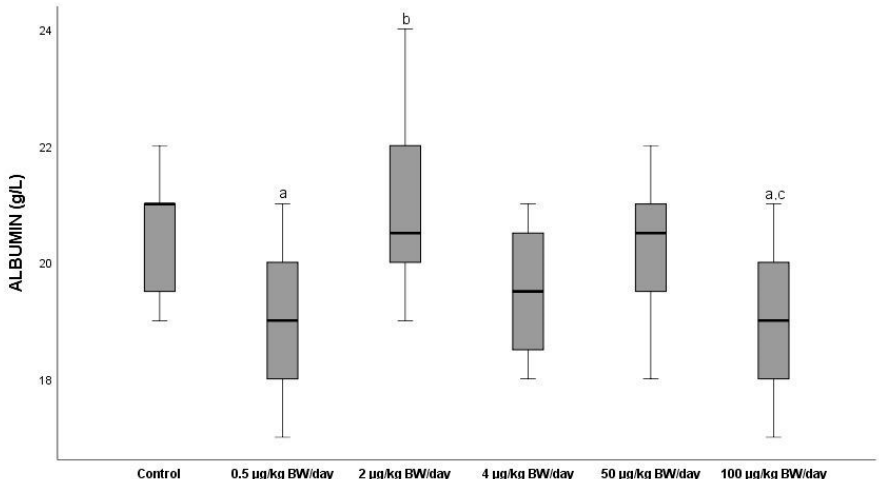
Figure 4. Means ± standard deviations of the serum levels of albumin (ALB) expressed in g/L in the different exposure groups. a significant differences vs. control ( p < 0.05) (G0); b significant differences vs. 0.5 µg/kg BW/day (G1); c significant differences vs. 2 µg/kg BW/day (G2).